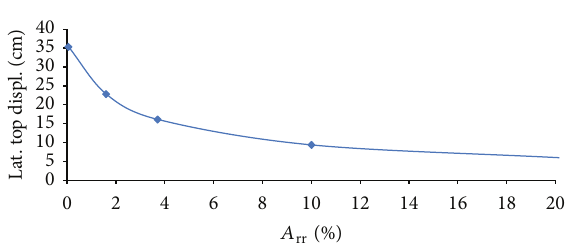
Figure 9: 𝐴 -longitudinal top displacement assessment. rr